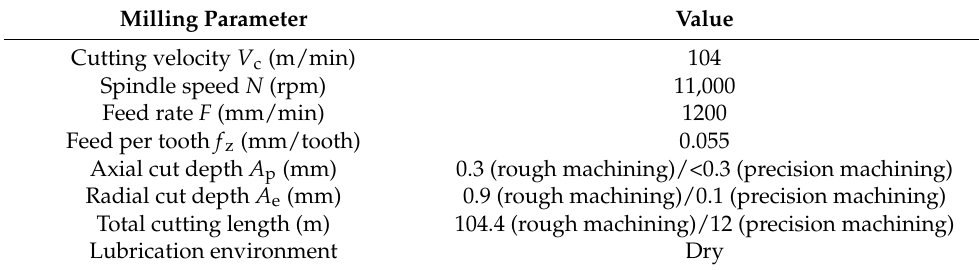
Figure 6. Experimental setup for high-speed machine tool: ( a ) photograph and ( b ) 3D model of machining area. Table 5. High-speed milling